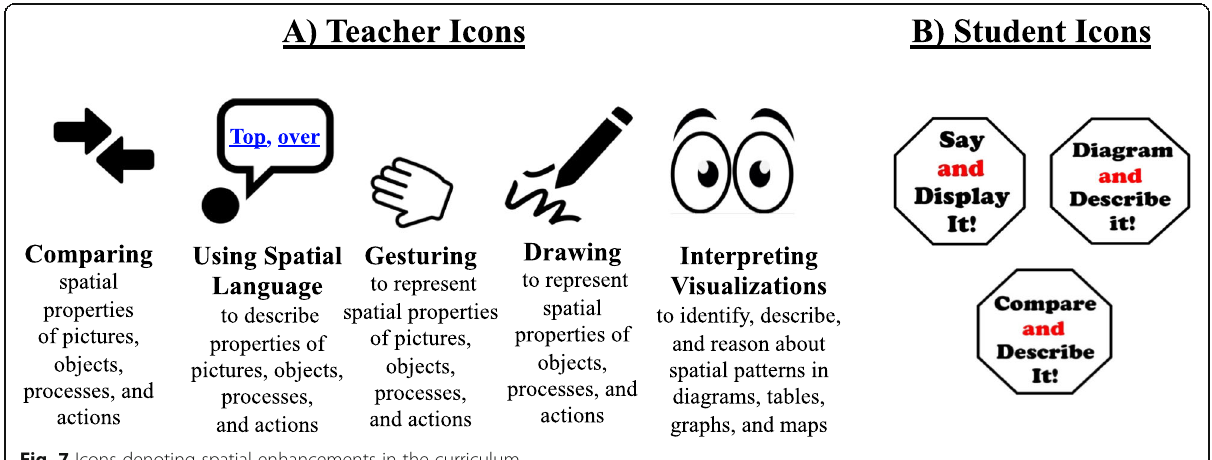
Fig. 7 Icons denoting spatial enhancements in the